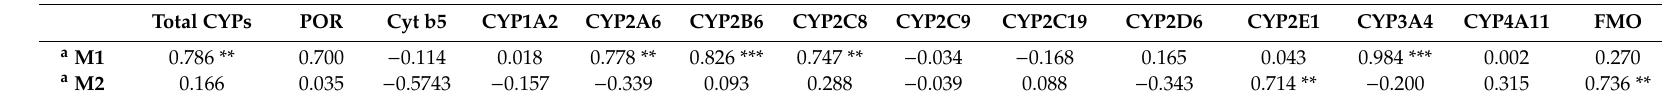
Table 3. Correlation coe ffi cients ( r ) among CYP- and FMO-linked catalytic activity and amounts of N -demethylvandetanib and vandetanib- N -oxide formed in